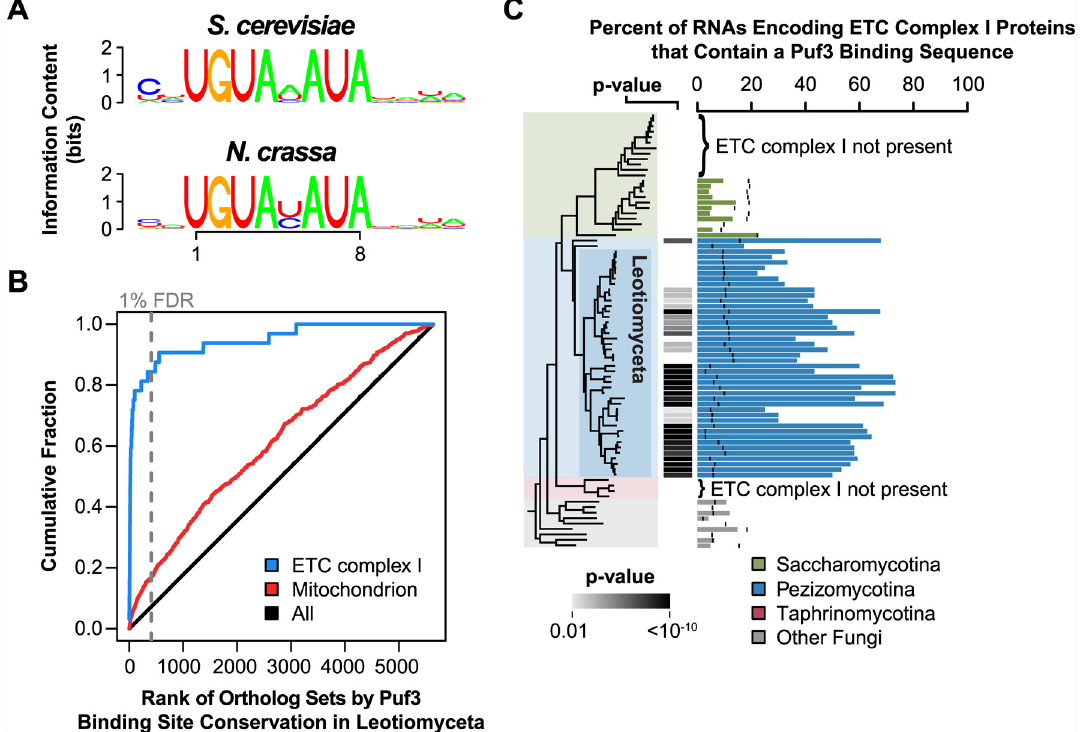
Fig 4. Binding specificity and targets of Leotiomyceta Puf3. (A) Motifs identified by the motif discovery program FIRE [82] within the 3' UTRs of S . cerevisiae mRNAs associated with S . cerevisiae Puf3 or the ectopically expressed N . crassa Puf3. FIRE identified eight nucleotide motifs, and these motifs were extended to display any preferences for flanking nucleotides. A match to the Puf3 motif UGUA[ACU]AUA is found in the 3' UTRs of 241 out of 392 (61%) of S . cerevisiae Puf3 targets and 83 out of 250 (33%) of mRNAs associated with N . crassa Puf3. The motif frequency across all 3' UTRs is 11%. Position frequency matrices can be found in S5 Dataset. (B) Cumulative distributions based on the ranked conservation score for Puf3 sites across Leotiomyceta species. The gray dashed line represents the 1% false discovery rate (FDR) cutoff for ortholog sets within which Puf3 sites are considered conserved. N . crassa annotations were used to define mitochondrion and electron transport chain (ETC) complex I groups [83]. Annotations and conservation scores can be found in S7 Dataset. (C) The percent of 3' UTRs of transcripts encoding components of ETC complex I that have a Puf3 binding site sequence. A black vertical bar marks the background frequency of the Puf3 motif for each species. A significant p -value indicates that Puf3 motif matches are enriched in complex I encoding RNAs relative to all other transcripts. The p -value was computed using Fisher's exact test and is corrected for multiple hypothesis testing. The multi-subunit, transmembrane complex I was independently lost in several fungal lineages, and species lacking this complex are noted. Percentages and p -values can be found in S1 Dataset.